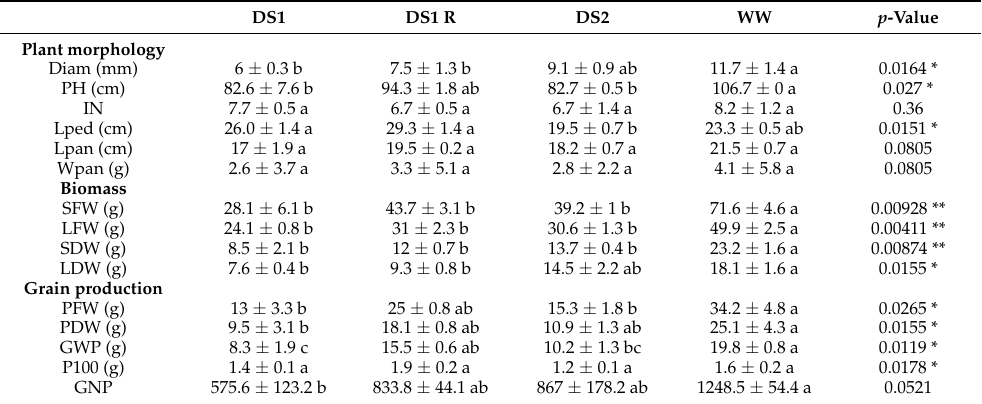
Table 2. Plant morphology, stem and leaf biomass, and grain production at physiological maturity, compared among different water